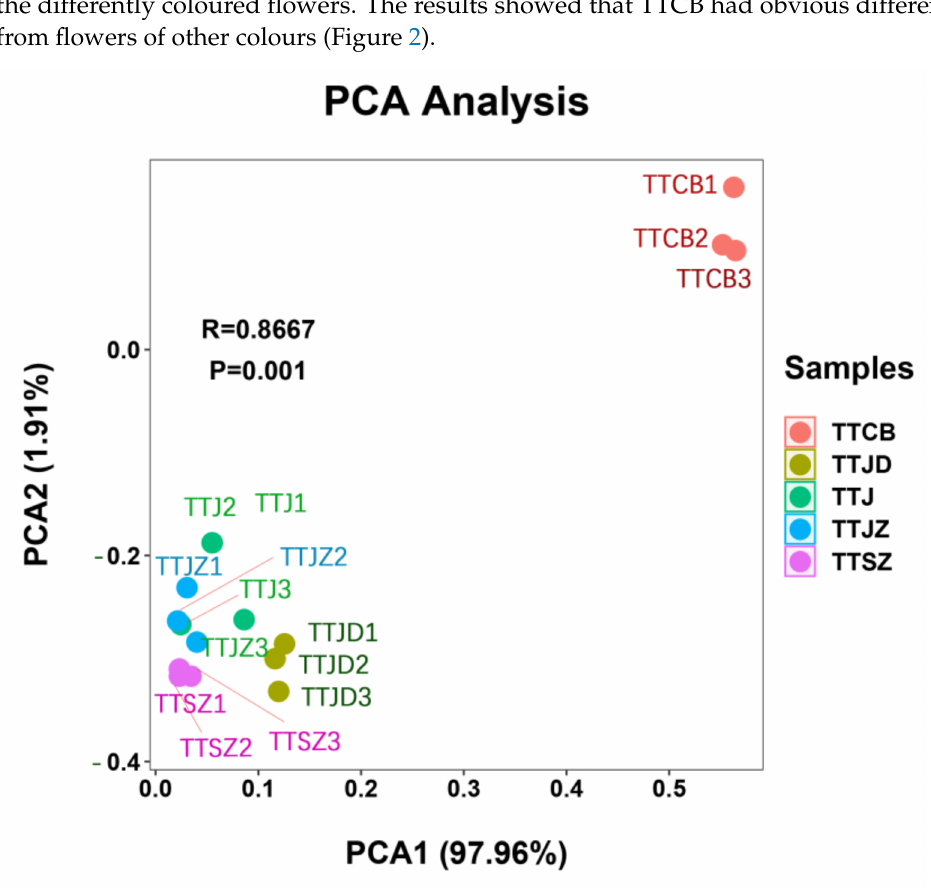
Figure 2. Plots of principal component analysis (PCA) of flower of different